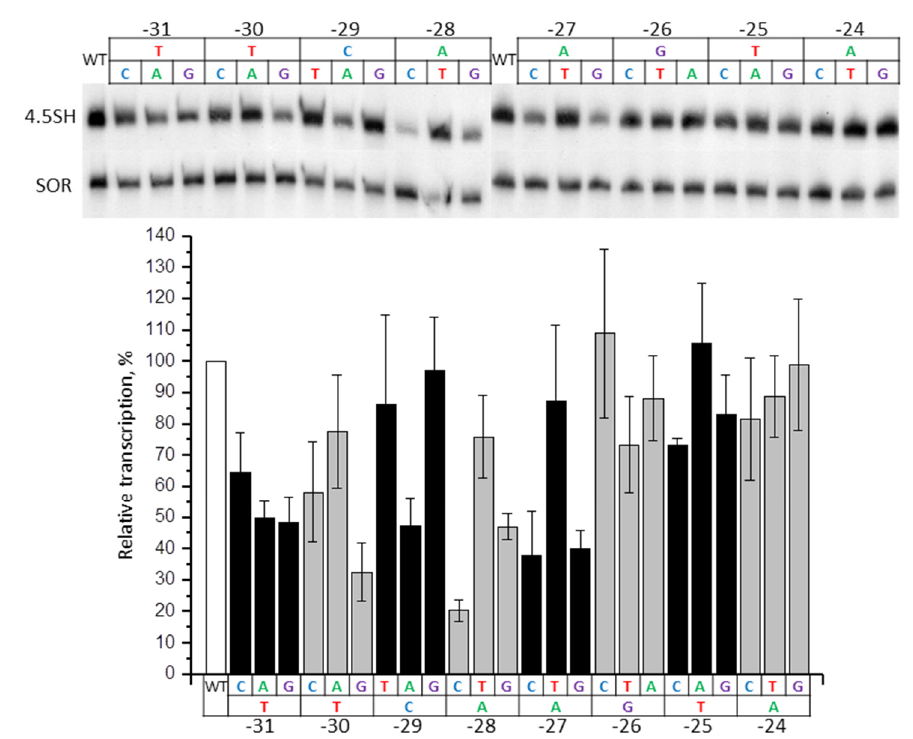
Figure 3. Effect of single nucleotide substitutions in –31/–24 box of 4.5SH RNA gene ( Mmu1 ′ ) on its transcription. Upper panel: 4.5SH gene transcripts detected by Northern hybridization in HeLa cells transfected by constructs, with the replacement of each nucleotide by three other ones in the –31/–24 box. SOR SINE was transfected along with the 4.5SH RNA gene and was used as a control. Lower panel: quantitative analysis of the Northern hybridization data. The transcription level of the gene without nucleotide substitutions (WT) is taken as 100% (error bars, SD, n = 4).